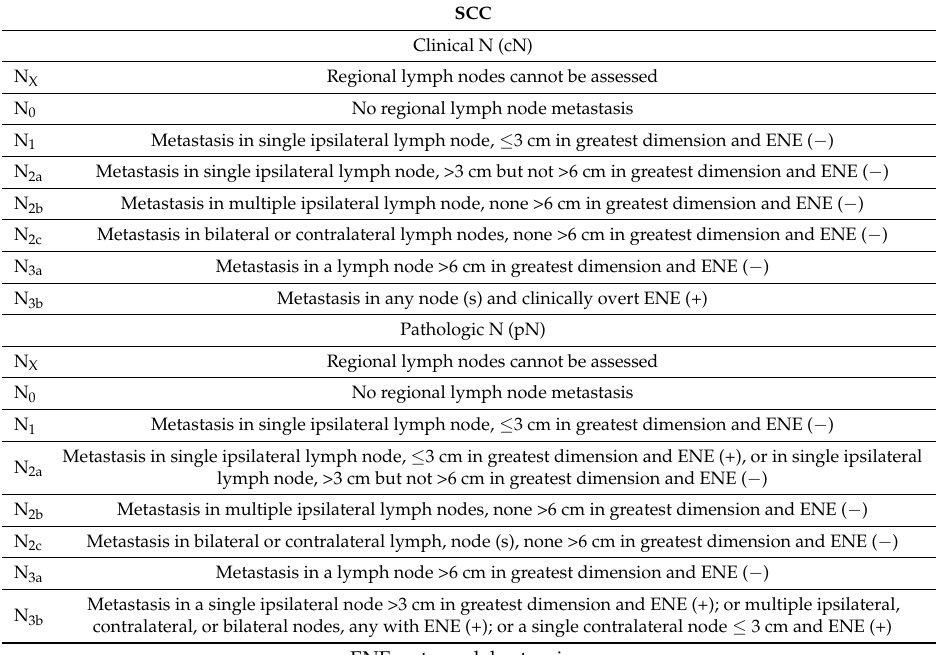
Table 2. American Joint Committee on Cancer Tumor (N) Classification, 8th Edition [65].